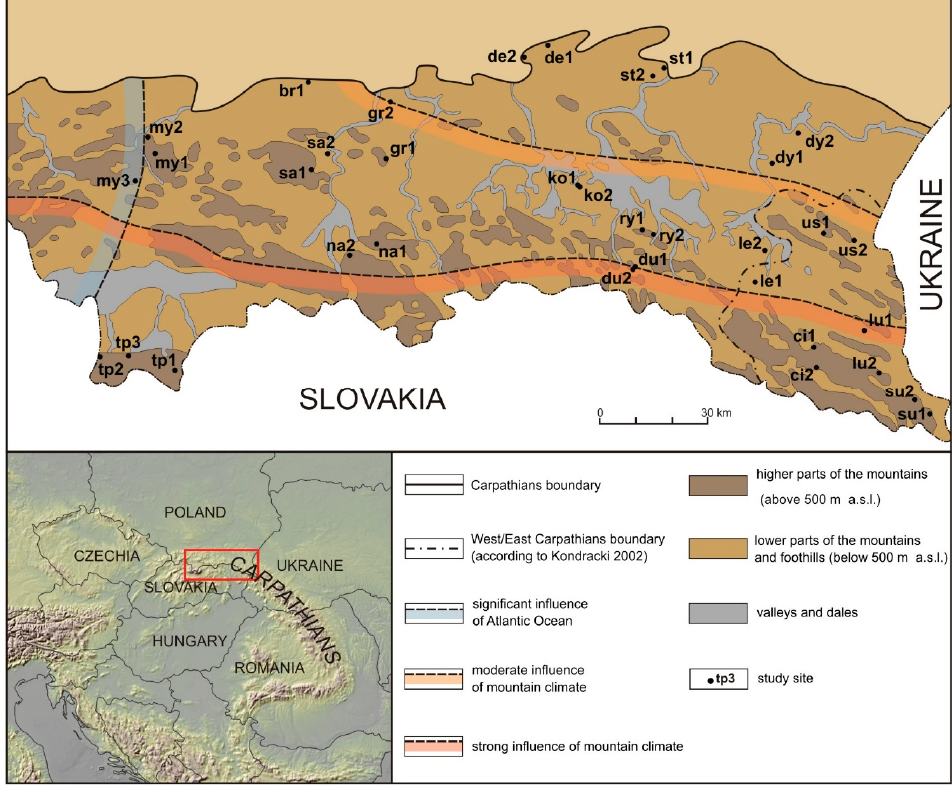
Figure 1. Study area with topography, climate, and site locations (compare [37] and